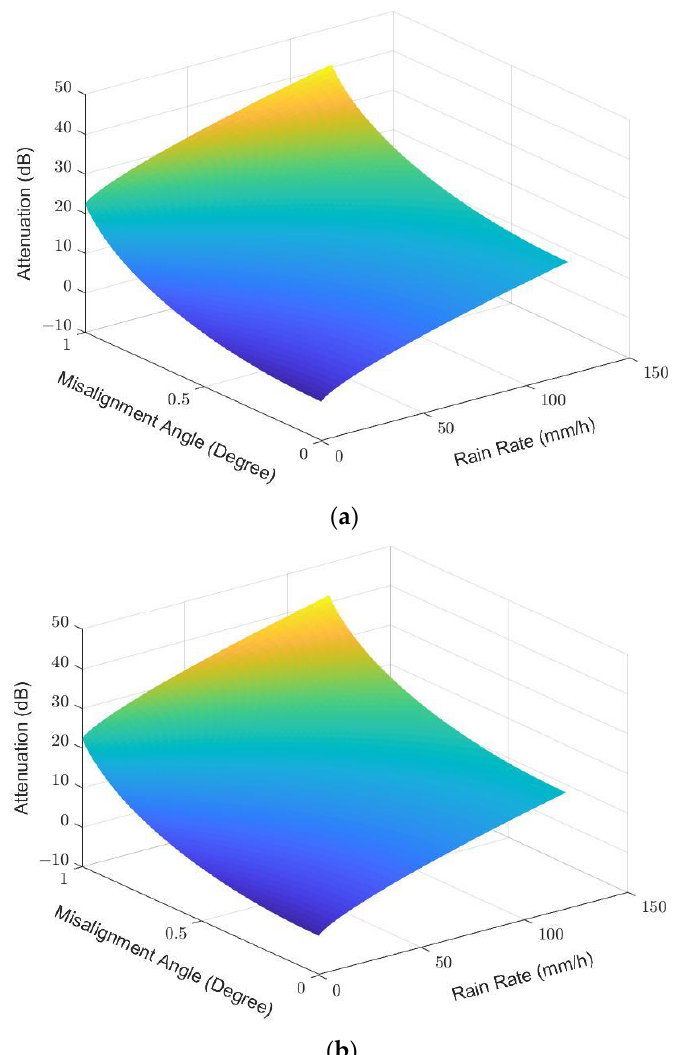
Figure 15. 3D plot of the attenuation as the function of rain rate and misalignment angle for ( a ) the vertical polarization and ( b ) the horizontal polarization.